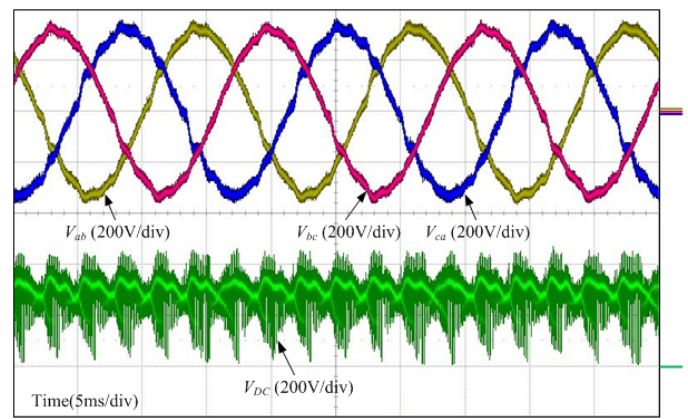
Figure 13. Block diagram of the experimental set.